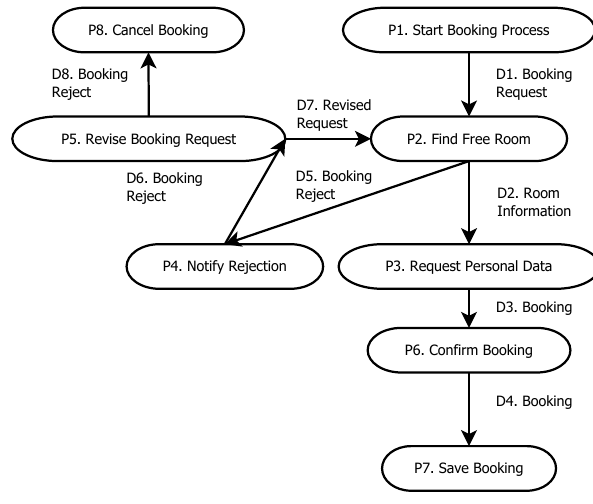
Fig. 14. Sample business process diagram.